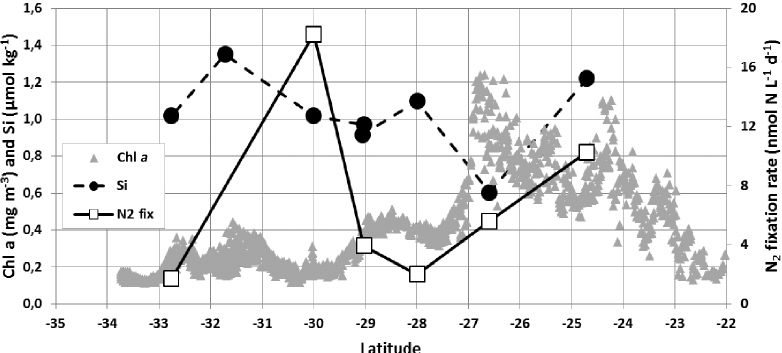
Figure 8. Sea surface silicate concentration (Si, µmolkg − 1 , black circles, scale on the left), N 2 fixation rate (N 2 fix, nmol NL − 1 d − 1 , open squares, scale on the right) measured in January 2020 (OISO-30 cruise) and Chl a (mgm − 3 , grey triangles, scale on the left) from MODIS (4km × 4km) along the cruise track. The low Si concentration (0.6µmolkg − 1 ) recorded around 27 ◦ S was linked to higher Chl a (up to 1.2mgm − 3 ) in the